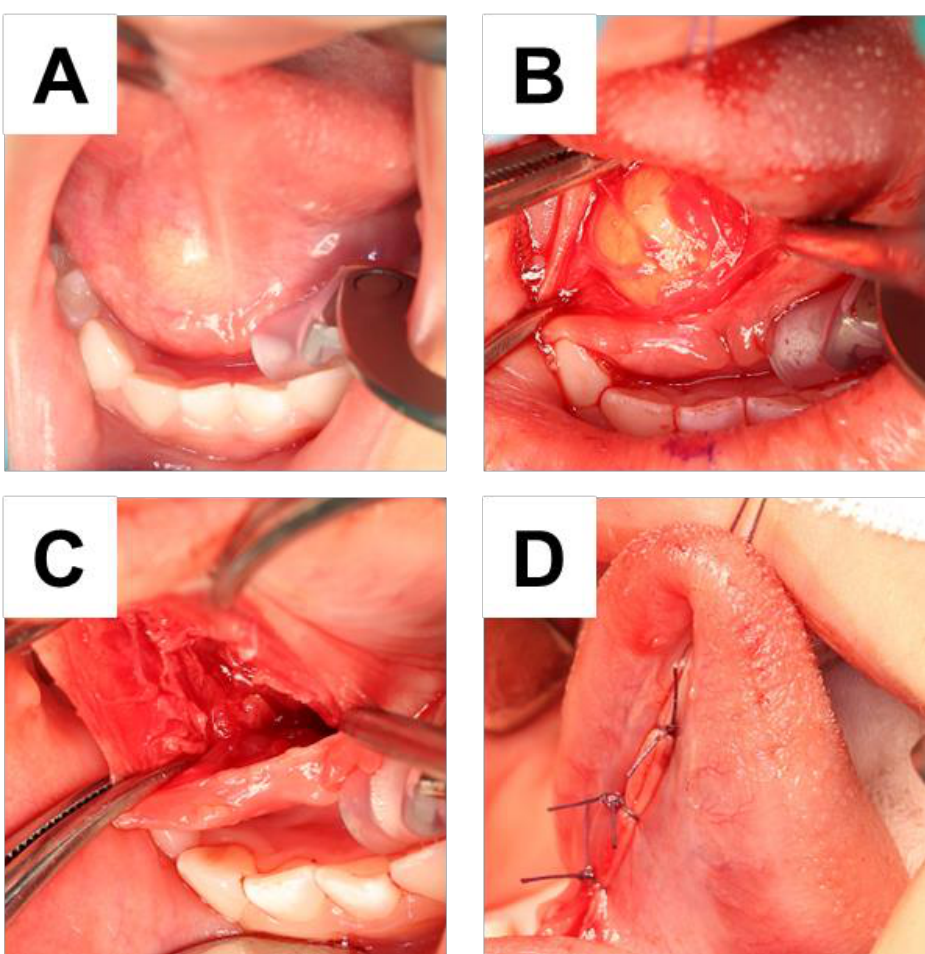
Figure 3. Intraoperative appearance. ( A ) Before operation. ( B ) Lesion appearance after incision. ( C ) After removal. ( D ) After suturing.